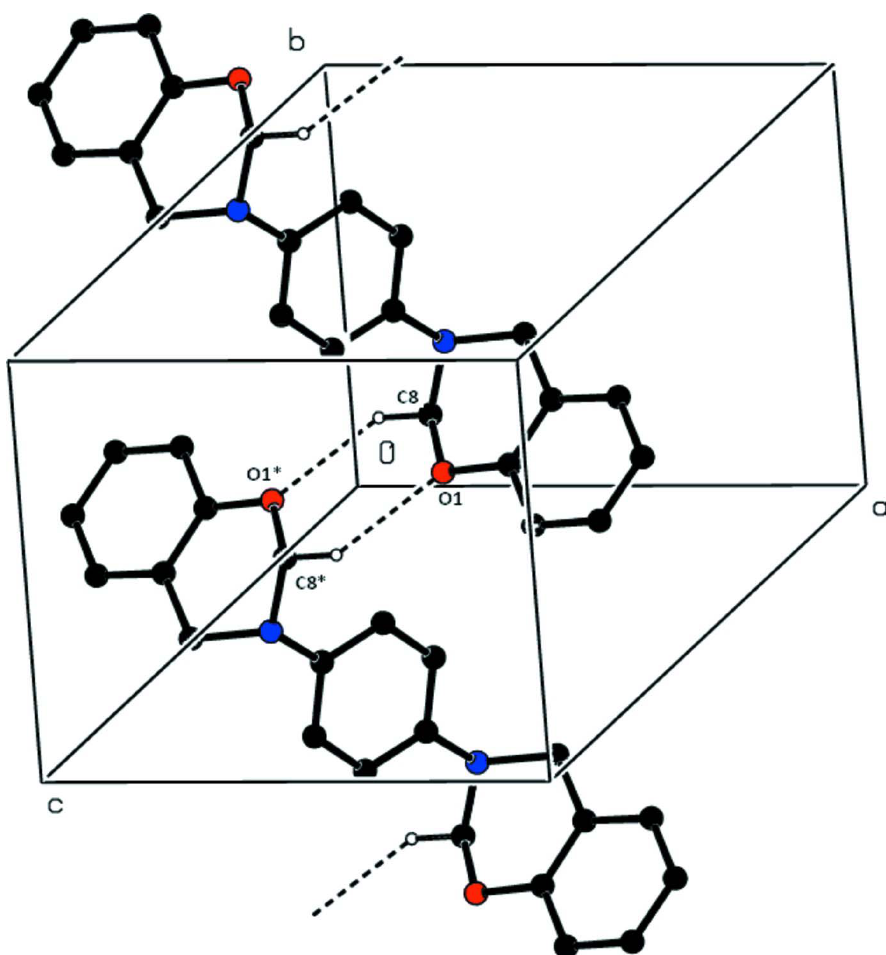
Figure 2 The crystal structure showing the centrosymmetric hydrogen bond motif R 22 (6). For the sake of clarity, the H atoms not involved in the motif have been omitted. The atoms marked with an asterisk (*) are situated in the position (2- x , 2- y , - z ). The dashed lines indicate the hydrogen